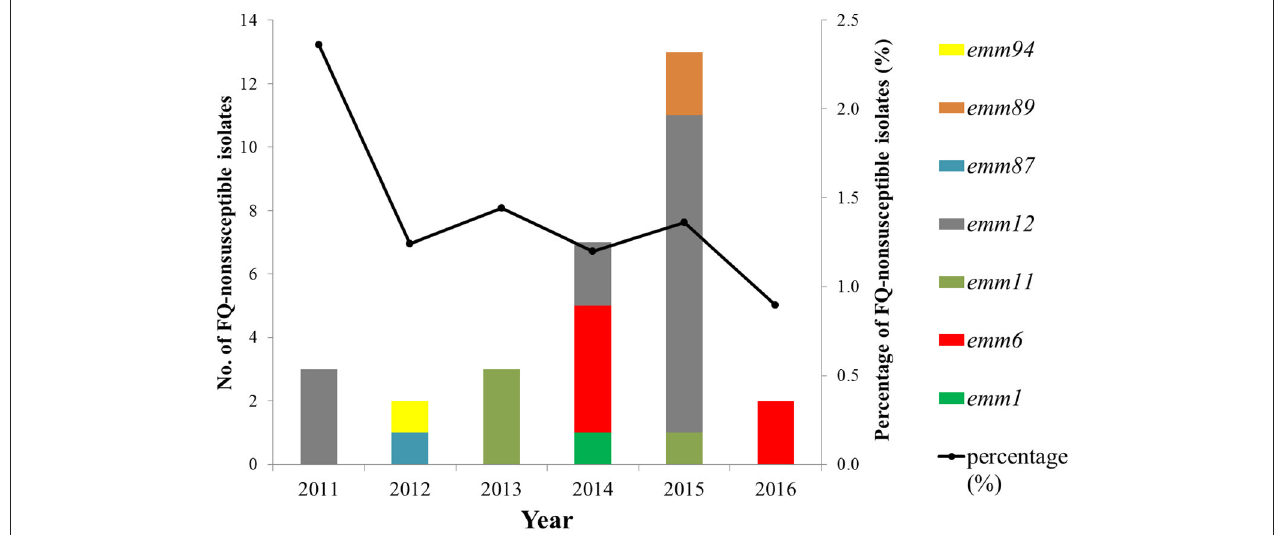
FIGURE 1 | Frequency and emm -type distribution of fluoroquinolone non-susceptibility in S. pyogenes strains isolated between 2011 to 2016 from Shanghai, China.